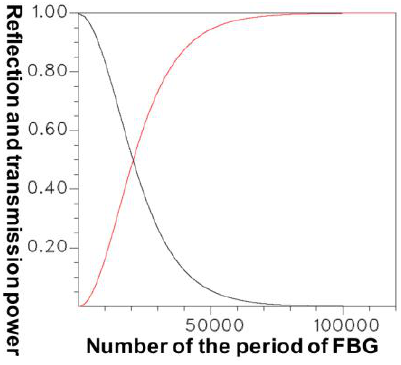
Figure 20. Plot between the FBG period number and the reflection (or transmission) power for the total coupling from HE to a counterpropagating cladding mode ( ν = 21) with 11 N = 120,000 and Λ = 0.53537 μm. The black line expresses the core mode transmission power. The red line expresses the cladding mode ( ν = 21) reflection power.